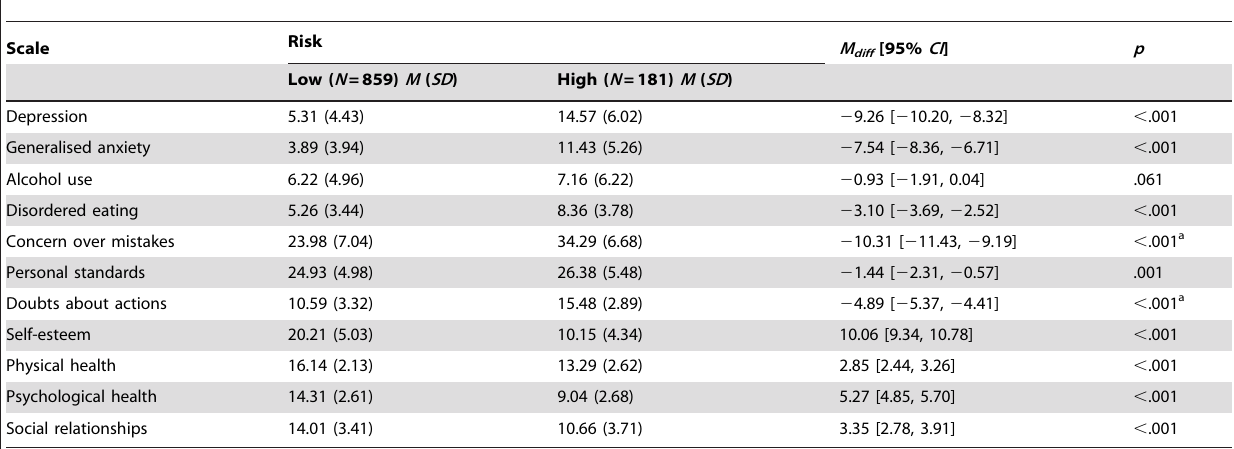
Table 3. Difference at baseline between students at high risk and low